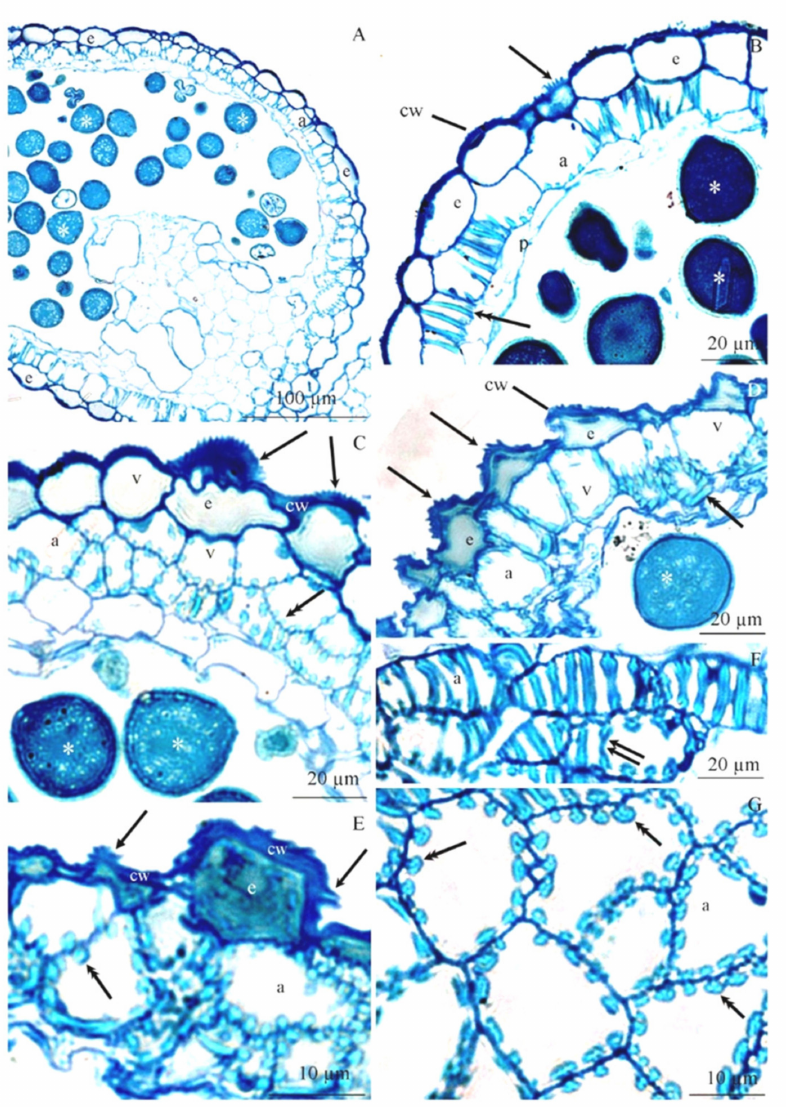
Figure 5. ( A – G ). Fragments of transverse and longitudinal sections of anthers at the white